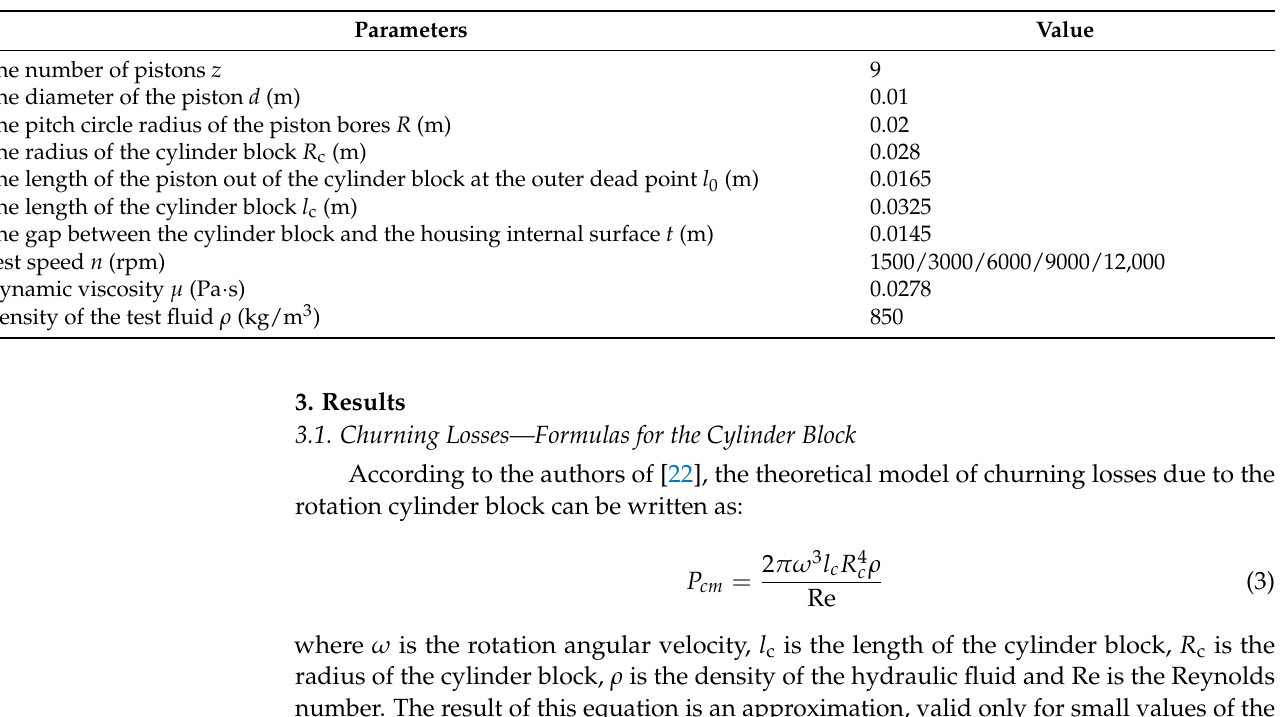
Table 1. Geometric dimensions and operating conditions of the test